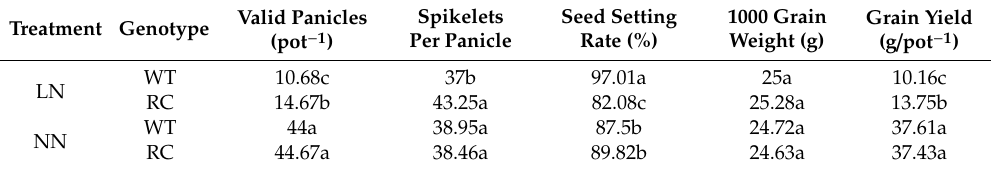
Table 1. Yield and yield components of rice under di ff erent nitrogen treatments in pots.